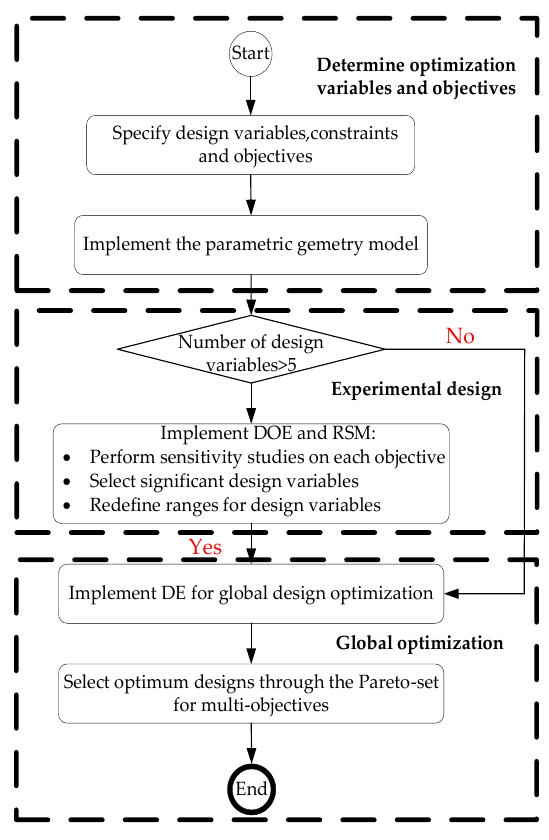
Figure 19. Machine optimization process based on DOE and DE [71].